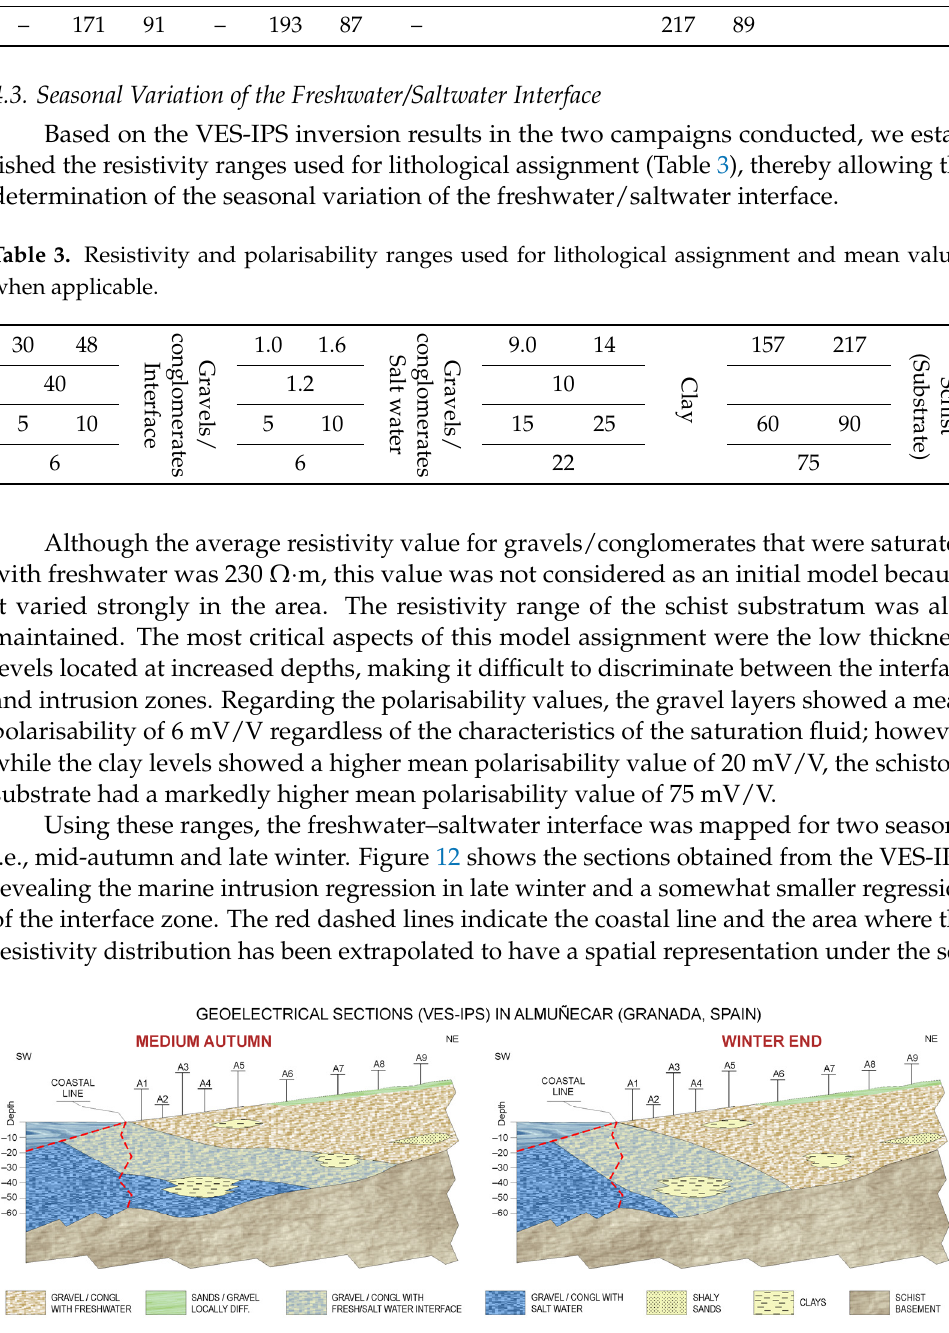
Figure 12. Sections showing the marine intrusion progress in two different